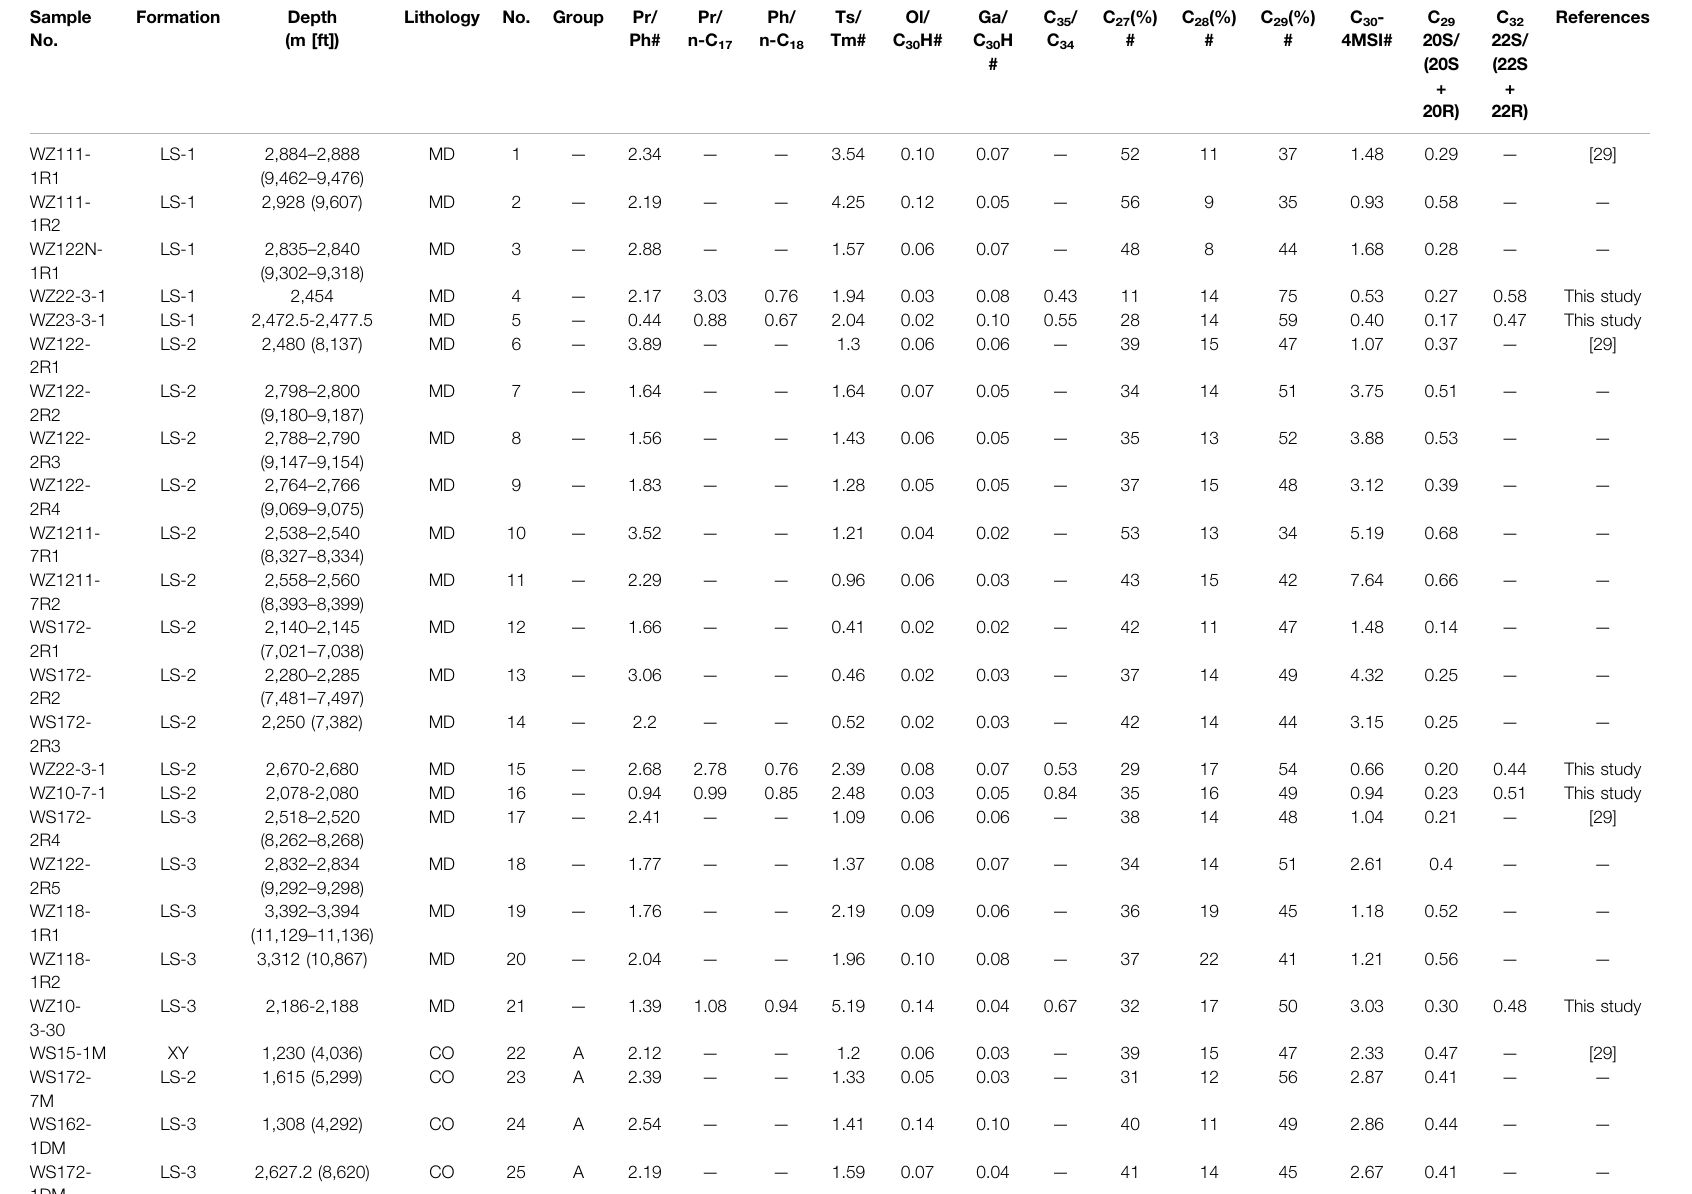
TABLE 2 | Selected geochemical parameters for the source rocks and crude oils in the Wushi Sag. Sample